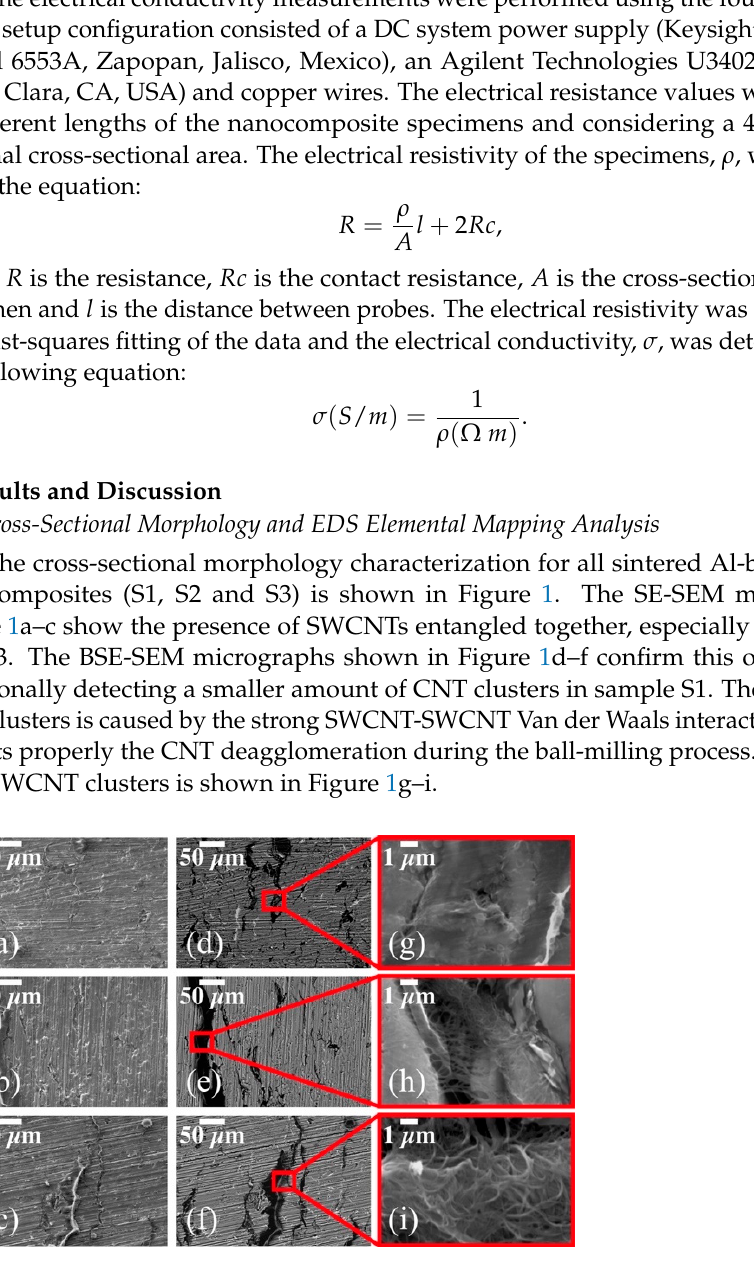
Figure 1. Cross-sectional SE-SEM ( a – c ) and BSE-SEM ( d – f ) micrographs for sintered nanocomposites S1, S2 and S3 reinforced with single-walled carbon nanotubes (SWCTNs) at 0.5 wt% 1 wt% and 2 wt%, respectively. The presence of the SWCNT clusters in ( g – i ) are caused by the strong SWCNT–SWCNT Van der Waals interaction.